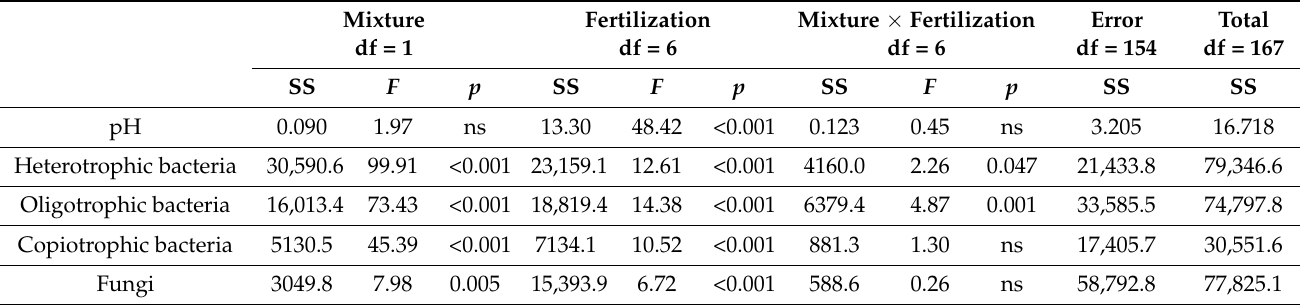
Table 3. Two-way ANOVA analyses of influence of fertilization and plant mixture on soil pH and counts of microorganisms in 2018–2019 (n = 168).